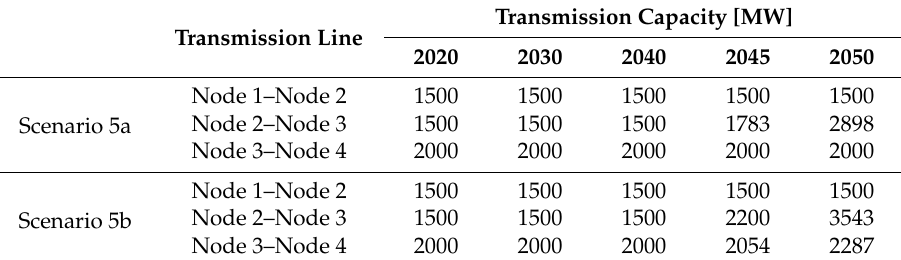
Table 9. Transmission capacity for Scenario 5.